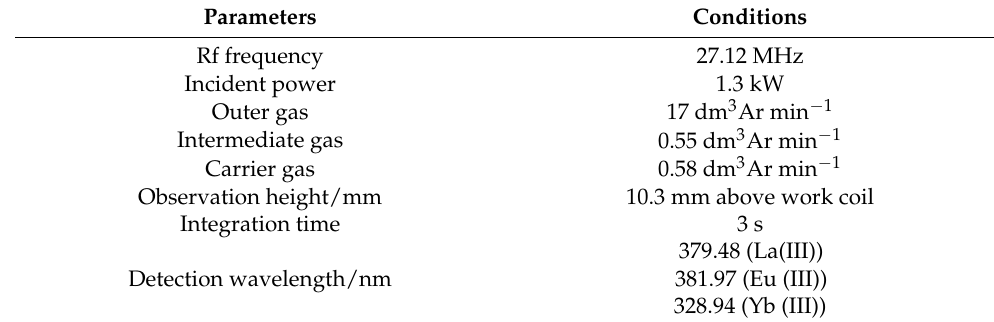
Table 6. Operating conditions of inductively coupled plasma atomic emission spectrometry (ICP-AES).